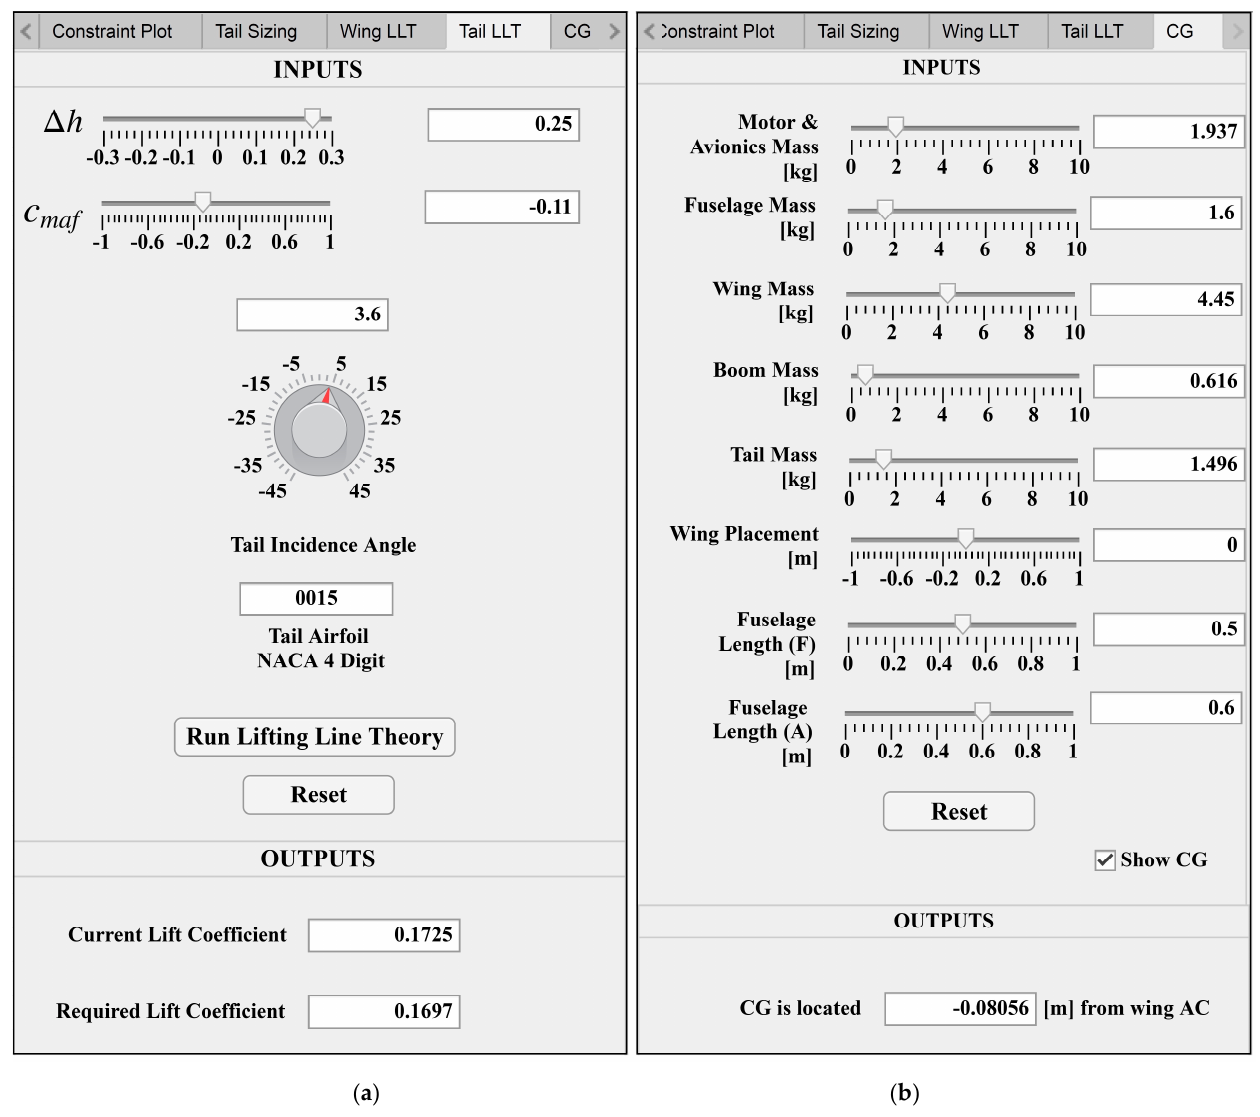
Figure 4. ( a ) Tail LLT input parameters, and ( b ) CG Calculator input parameters.